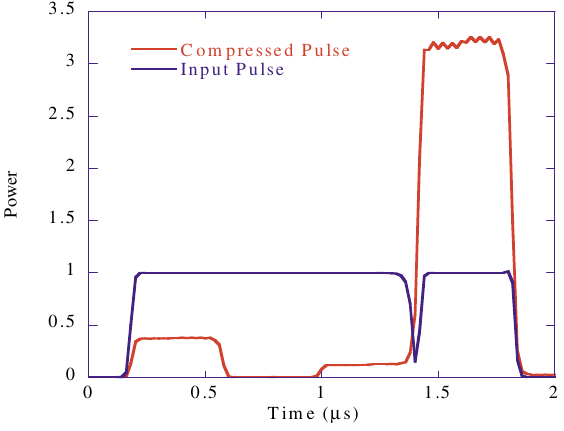
FIG. 11. (Color) Pulse compression system